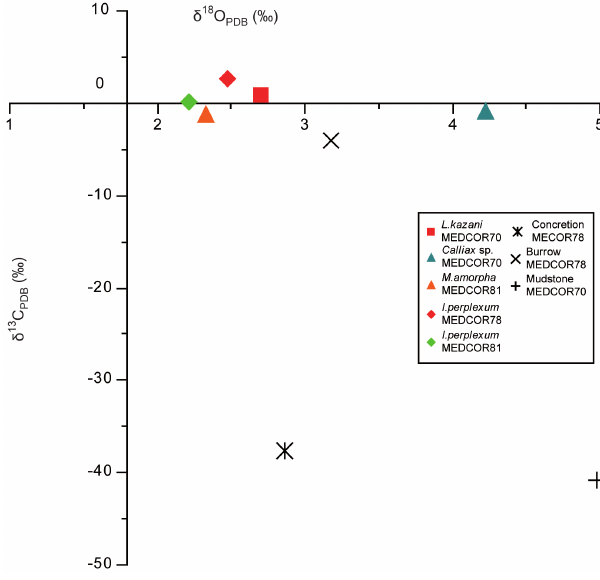
Fig. 12. Stable isotope compositions of bivalve shells (core MED- COR 81), callianassid claw and authigenic carbonates all from st. MEDCOR70 and MEDCOR78 expressed in the conventional δ no- tation relative to the PDB reference